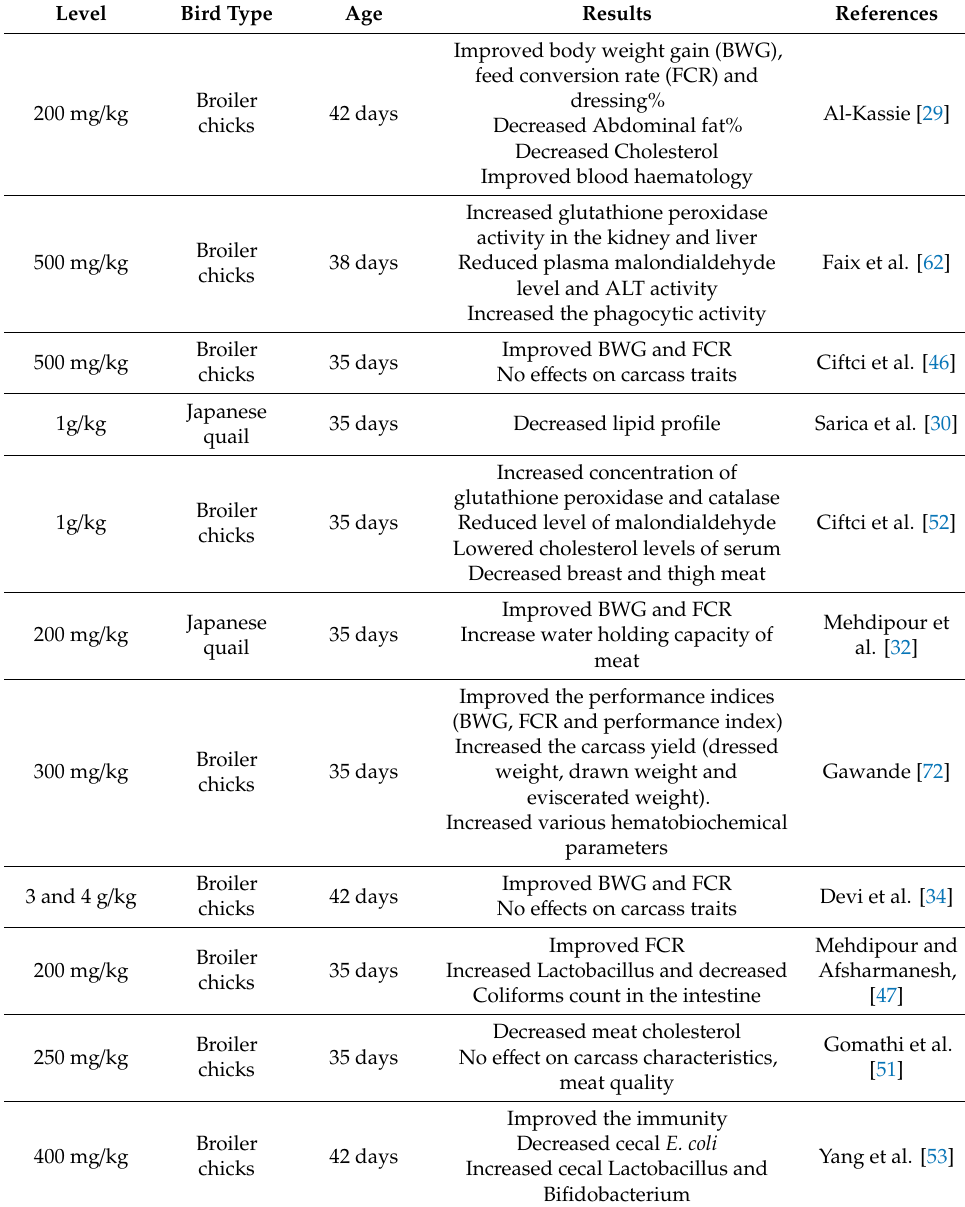
Table 2. Some e ff ects of cinnamon essential oil on